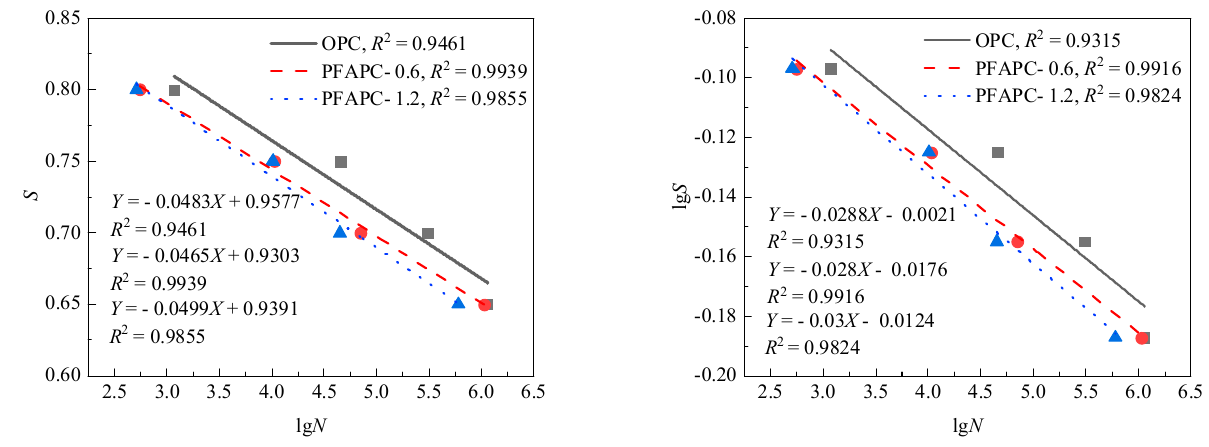
Table 10. Ultimate fatigue strength under two-parameter Weibull distribution.